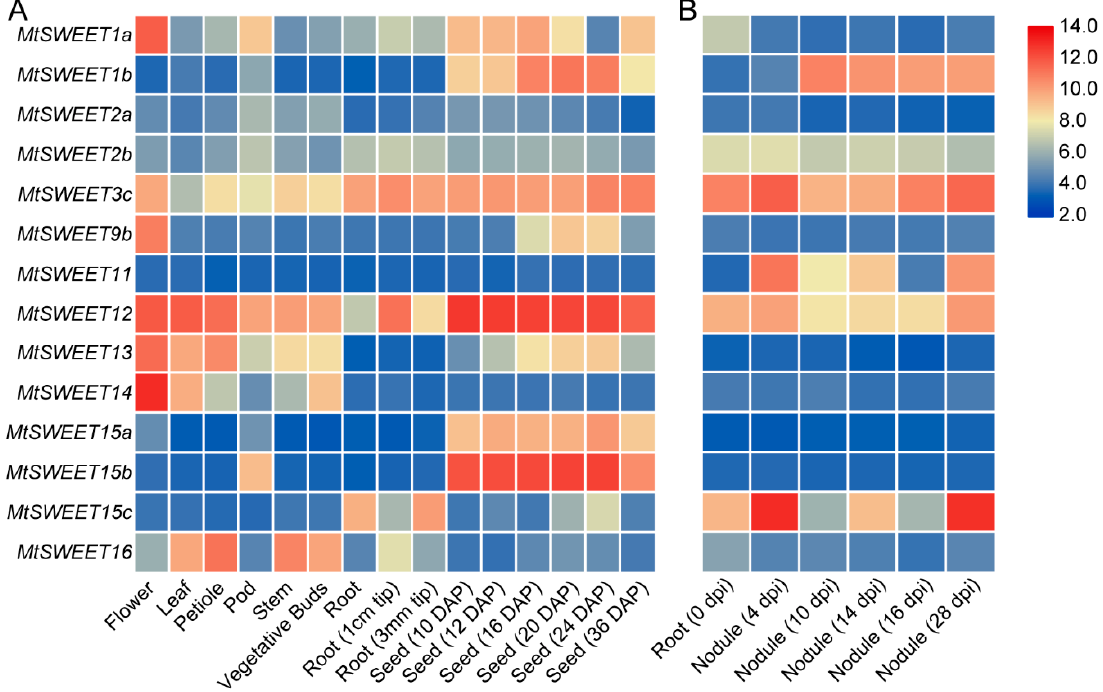
Figure 5. Expression analysis of the MtSWEET genes in different developmental tissues ( A ) and during nodule development ( B ) of M. truncatula using microarray data. The expression levels of the MtSWEET genes are shown as the log 2 -based fluorescence intensity values from the microarray data (MtGEA, https://mtgea.noble.org/v3/). DAP, days after pollination. dpi, days post inoculation.